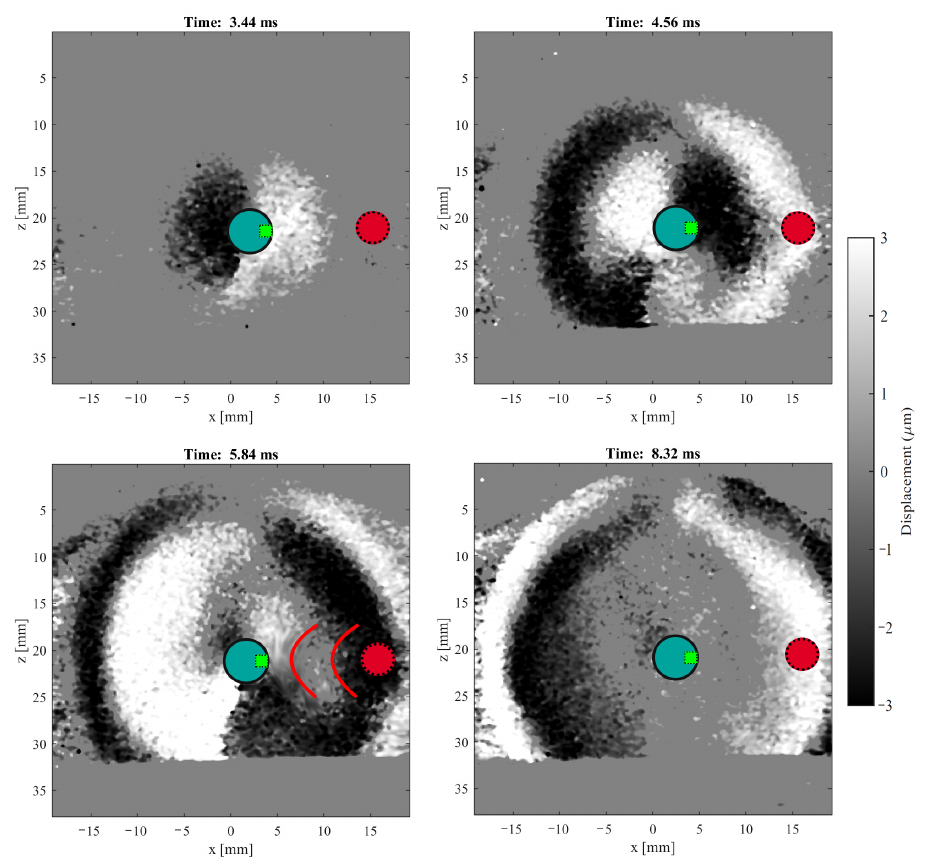
Figure 8. Example of ultrasound images at different times on the cross-section plane that contains the transluminal sensor (turquoise circle) in phantom B. The green sensor is facing the inclusion (red circle). The ultrasound probe scanned from the upper side of the